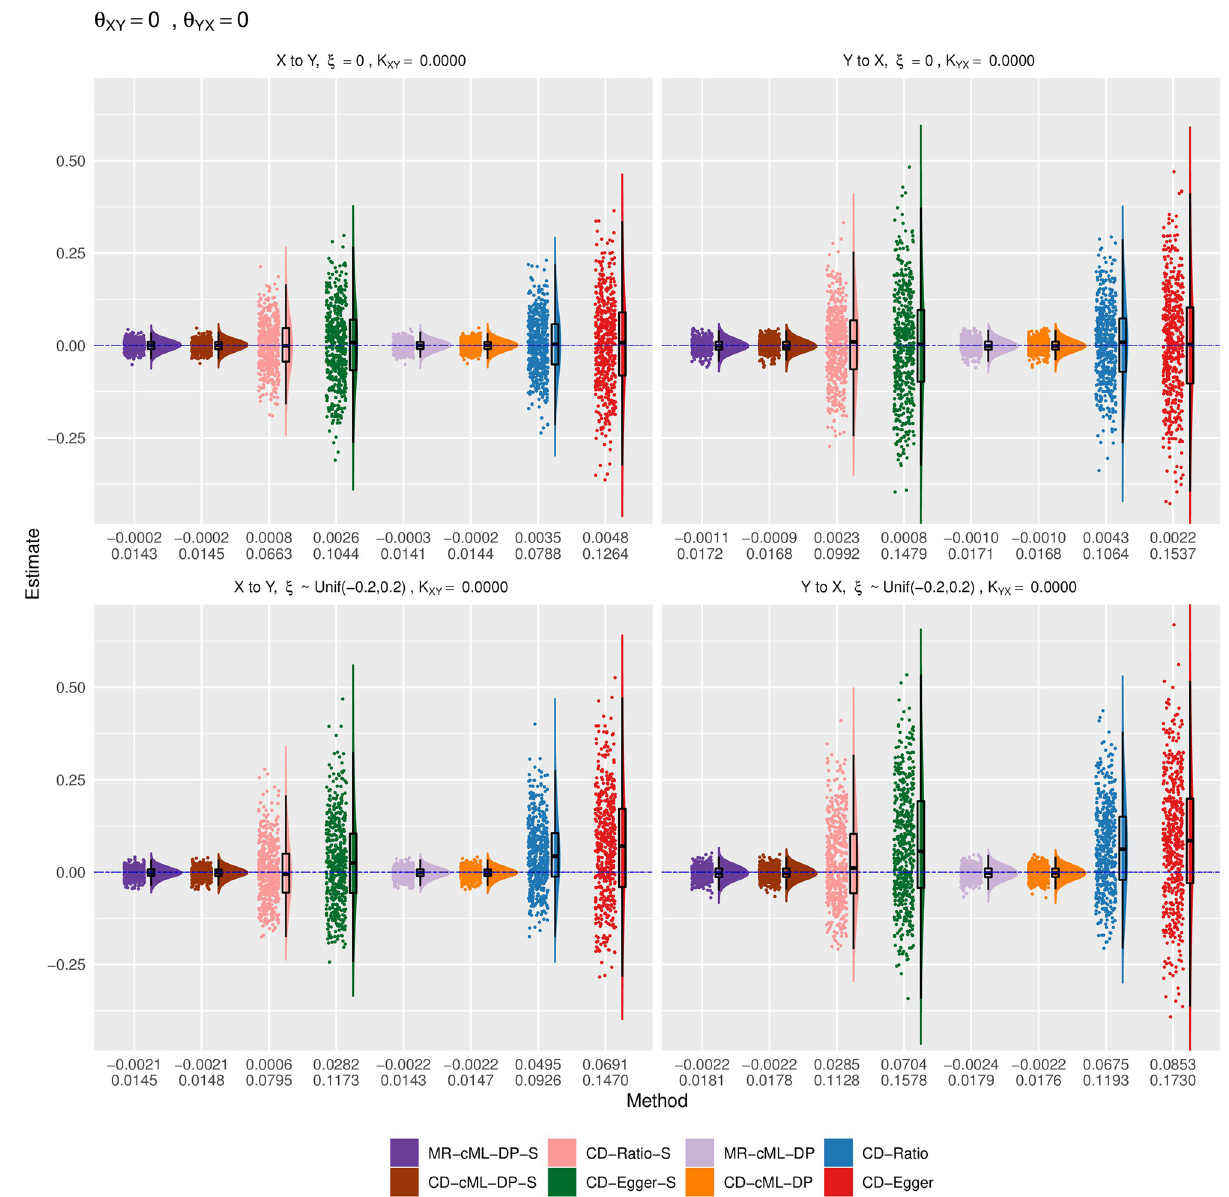
Fig 6. Empirical distributions of the estimates of the correlation ratio K for CD methods and the causal effect θ for MR method with both X and Y continuous, true θ XY = 0 and θ YX = 0. The top and bottom panels show the results for ξ = 0 (i.e. no correlated pleiotropy) and ξ from a uniform distribution (i.e. with correlated pleiotropy, implying InSIDE violated), respectively. The left panels show the estimates for the causal direction of X ! Y , while the right ones show that for Y ! X . The horizontal dashed lines are for the true values of K or θ . The two rows of the numbers under each panel give the sample mean and standard deviation of the estimates from each